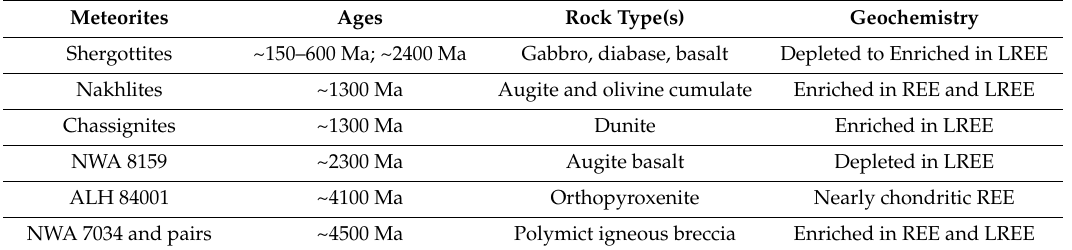
Table 1. Summary table of Martian meteorite ages, rock types, and